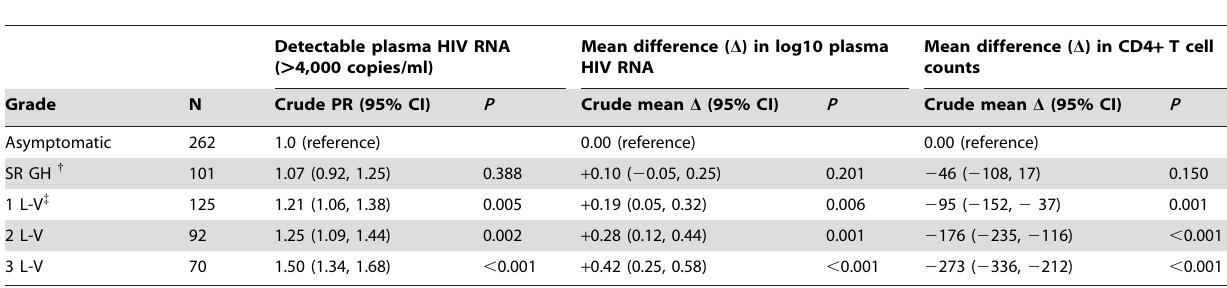
Table 3. Crude prevalence risk ratios (PRs) of detectable plasma HIV RNA and mean differences in plasma HIV RNA and CD4 + T cell counts (from the GEE analysis with robust variance estimation) by degree of HSV-2 clinical activity.